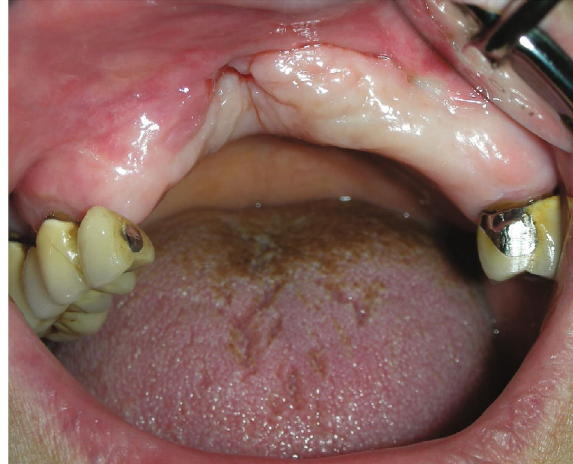
Figure 11: Intraoral appearance 2 weeks after graft rejection. Anterior mucosal envelope collapsed due to the lack of structural support, showing the wide anterior maxillary